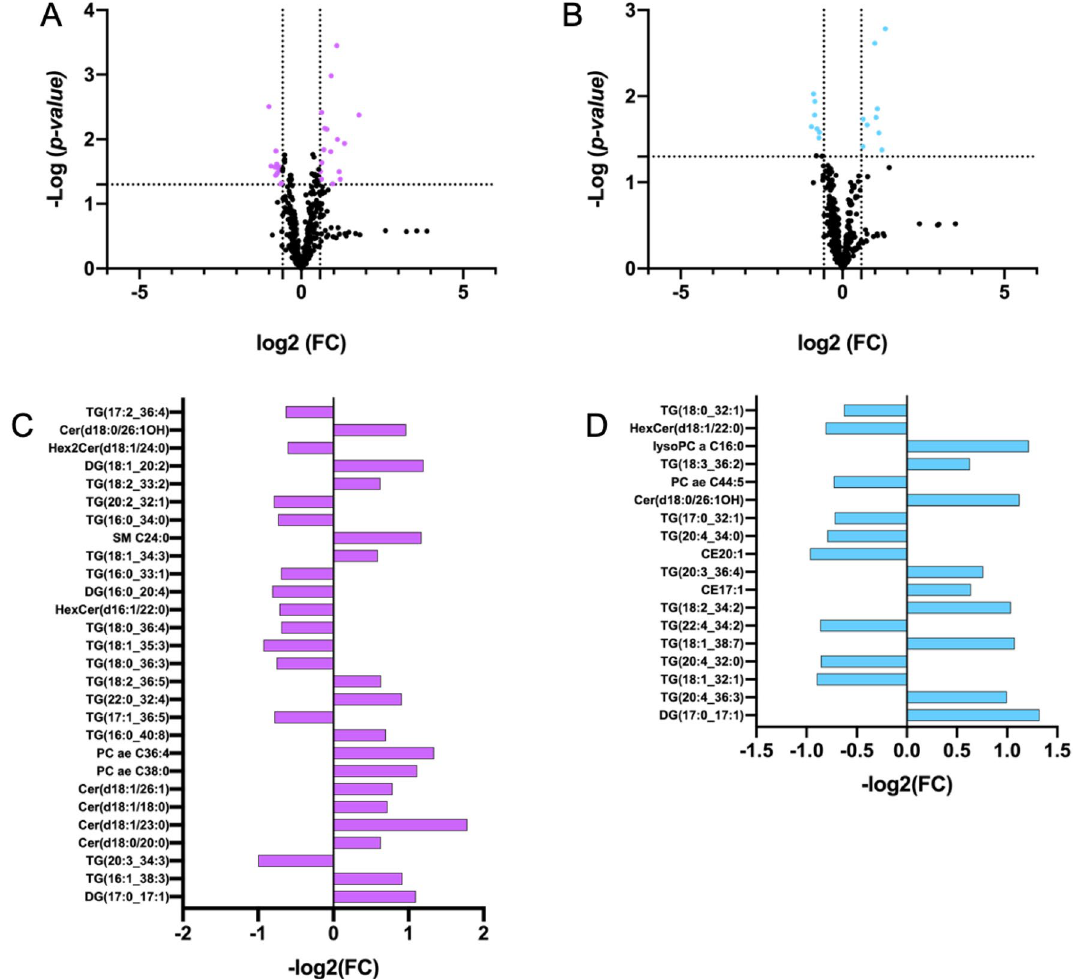
Figure 2. Targeted lipidomic analyses. Volcano plots of differential concentrations of 483 lipids in comparison of ( A ) severe patient serum to mild and ( B ) severe patient serum to moderate. The fold change of significant differentially abundant lipids ( p < 0.05) in ( C ) severe condition versus mild and ( D ) severe condition versus moderate were plotted according to their significant p-value , reported in Tables 1 and 2,